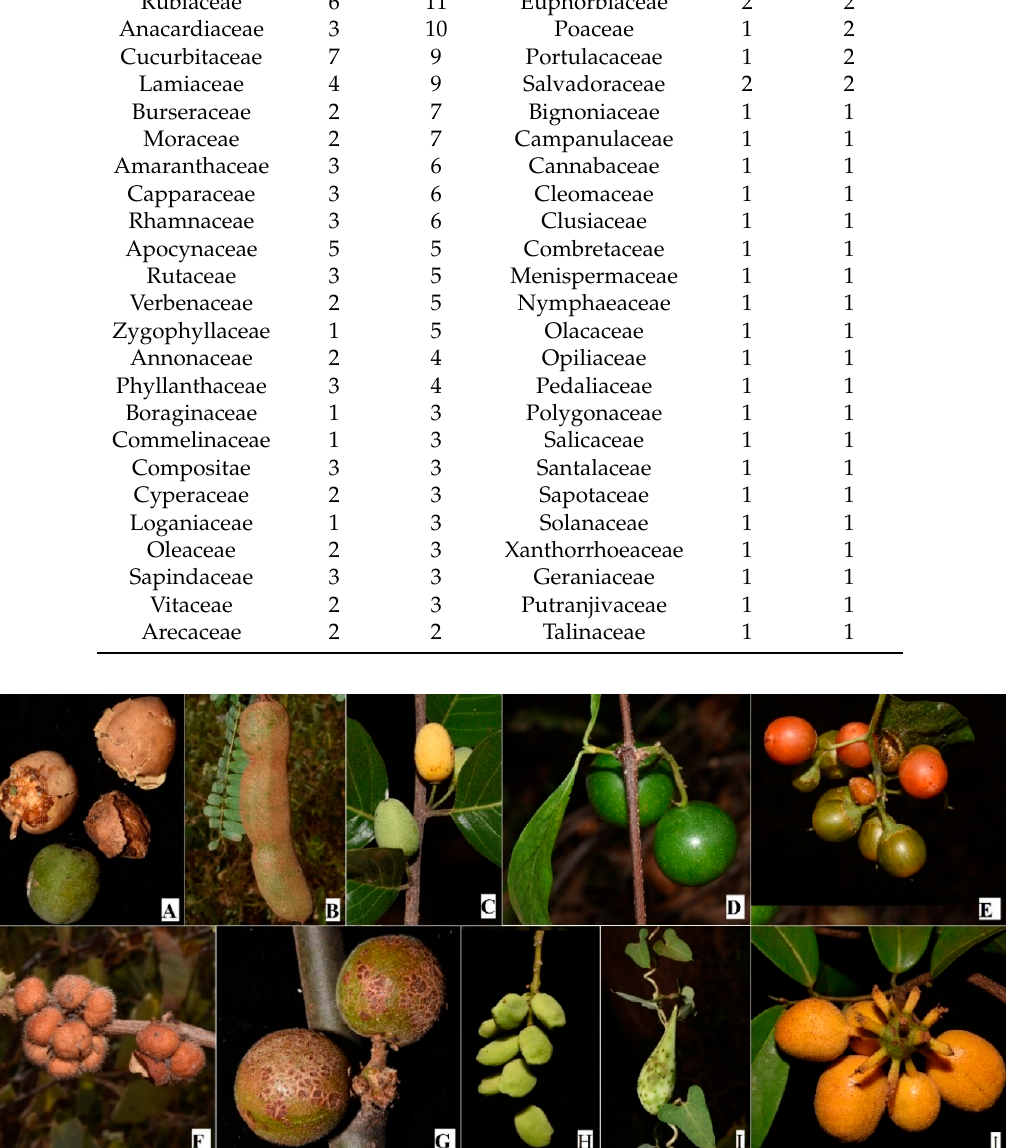
Figure 2. Some of the wild edible fruits encountered during field study in Kitui county: ( A ) Balanites aegyptiaca (L.) Delile (Zygophyllaceae); ( B ) Tamarindus indica L. (Leguminosae); ( C ) Berchemia discolor (Klotzsch) Hemsl. (Rhamnaceae); ( D ) Vangueria madagascariensis J.F.Gmel. (Rubiaceae); ( E ) Cordia sinensis Lam. (Boraginaceae); ( F ) Grewia villosa Willd. (Malvaceae); ( G ) Commiphora edulis (Klotzsch) Engl. (Burseraceae); ( H ) Lannea schweinfurthii Engl. (Anacardiaceae); ( I ) Cynanchum hastifolium K.Schum. (Apocynaceae); ( J ) Uvaria scheffleri Diels (Annonaceae). Table 1. Number of genera and species of wild edible plants in Kitui county by family.